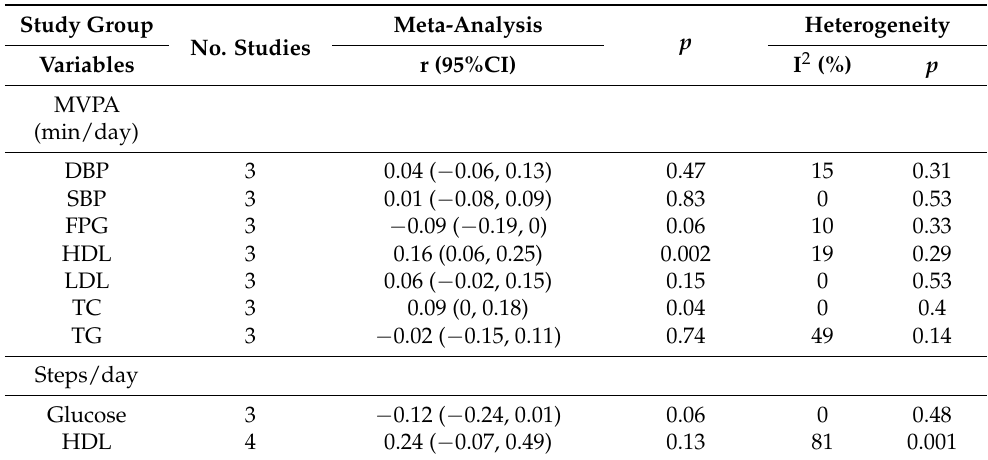
Table 4. The meta-analysis of the association between physical activity and cardiometabolic health outcomes (all analyses were performed using the random-effect